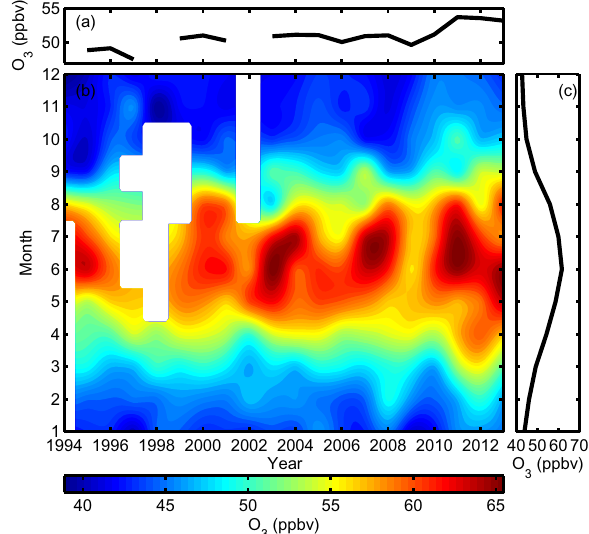
Figure 3. The average seasonal variation (a) , season–diurnal varia- tion (b) and diurnal variation (c) of ozone during 1995–2013. The red and white dots indicate the monthly average local times asso- ciated with the diurnal minimum ozone and the diurnal maximum zonal wind ( U max ) , respectively.